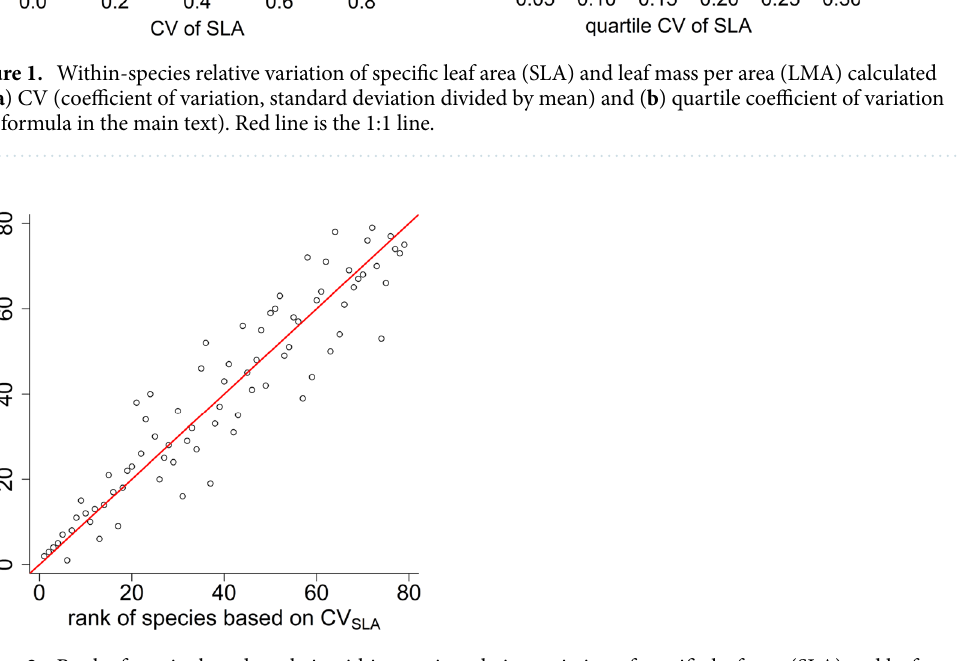
Figure 2. Rank of species based on their within-species relative variation of specific leaf area (SLA) and leaf mass per area (LMA) calculated by CV (coefficient of variation, standard deviation divided by mean). Red line is the 1:1